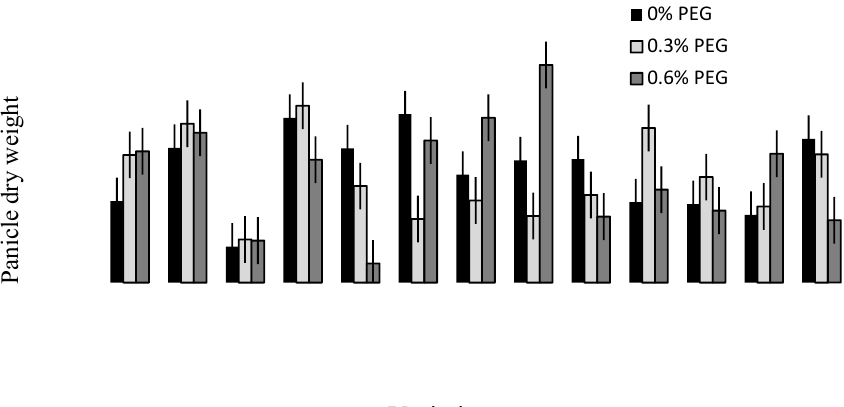
Figure 1. Panicle length (cm) of 13 wheat varieties with three different PEG treatments. PEG treatment was imposed for 60 days after sowing for 20 days.